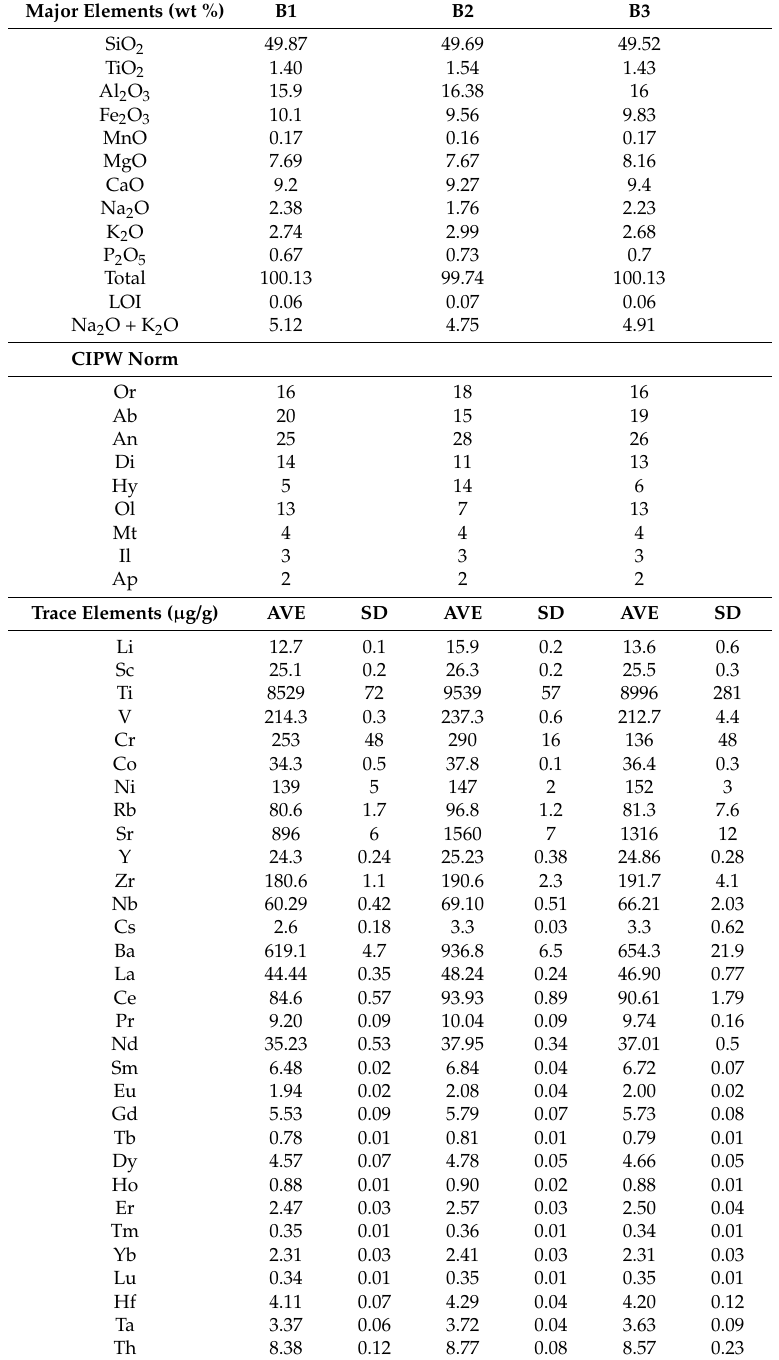
Table 1. Whole rock compositions of host basalt from the Bankawa alkali basalt from the SW Japan